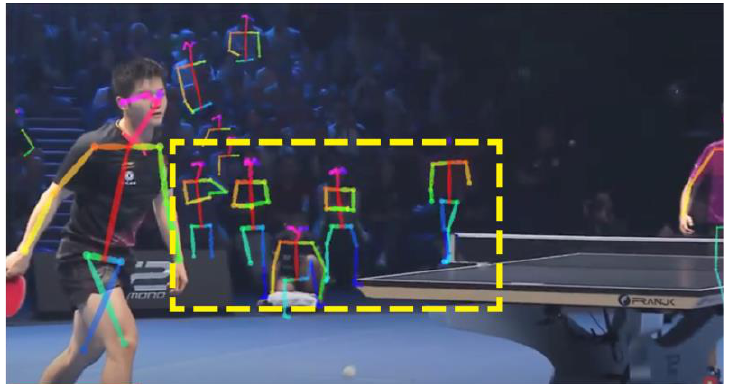
Figure 7. Interference of off-field persons (referee, coach).